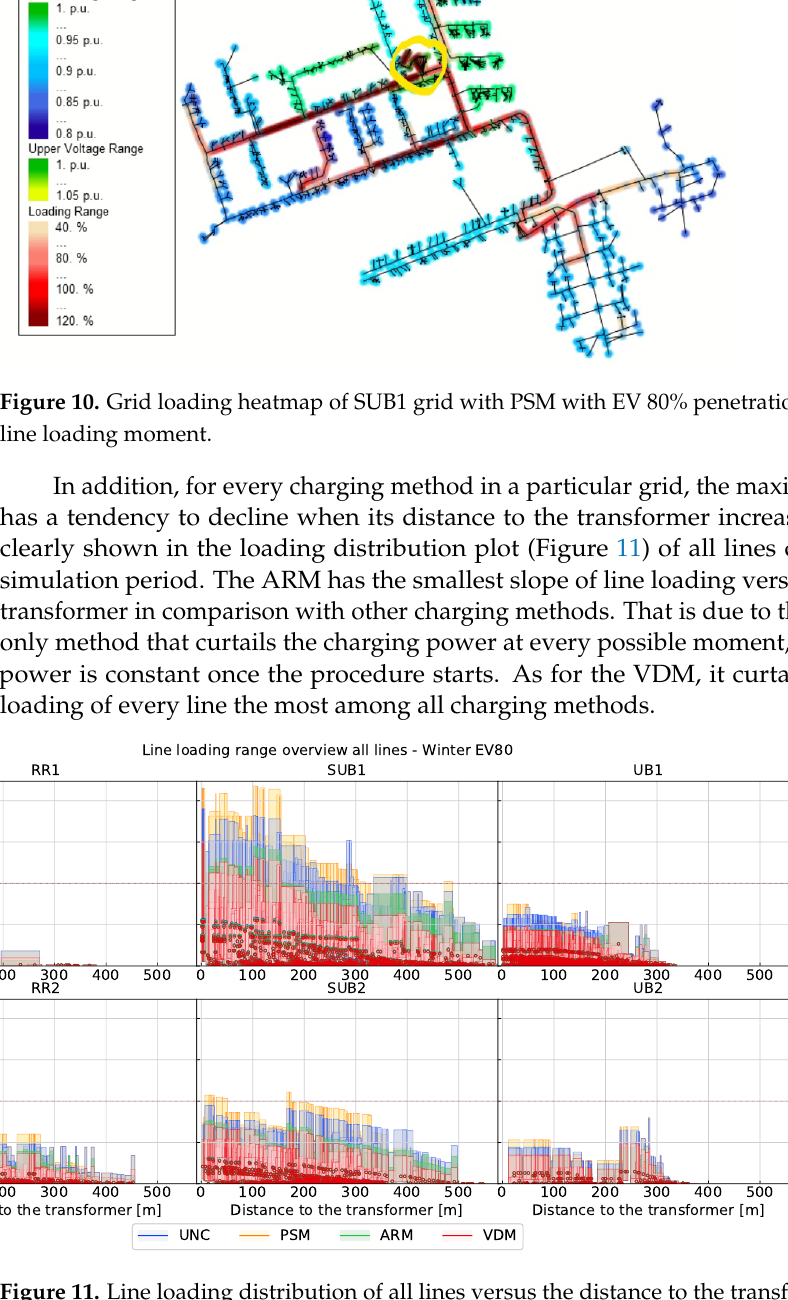
Figure 11. Line loading distribution of all lines versus the distance to the transformer with EV 80% penetration level in